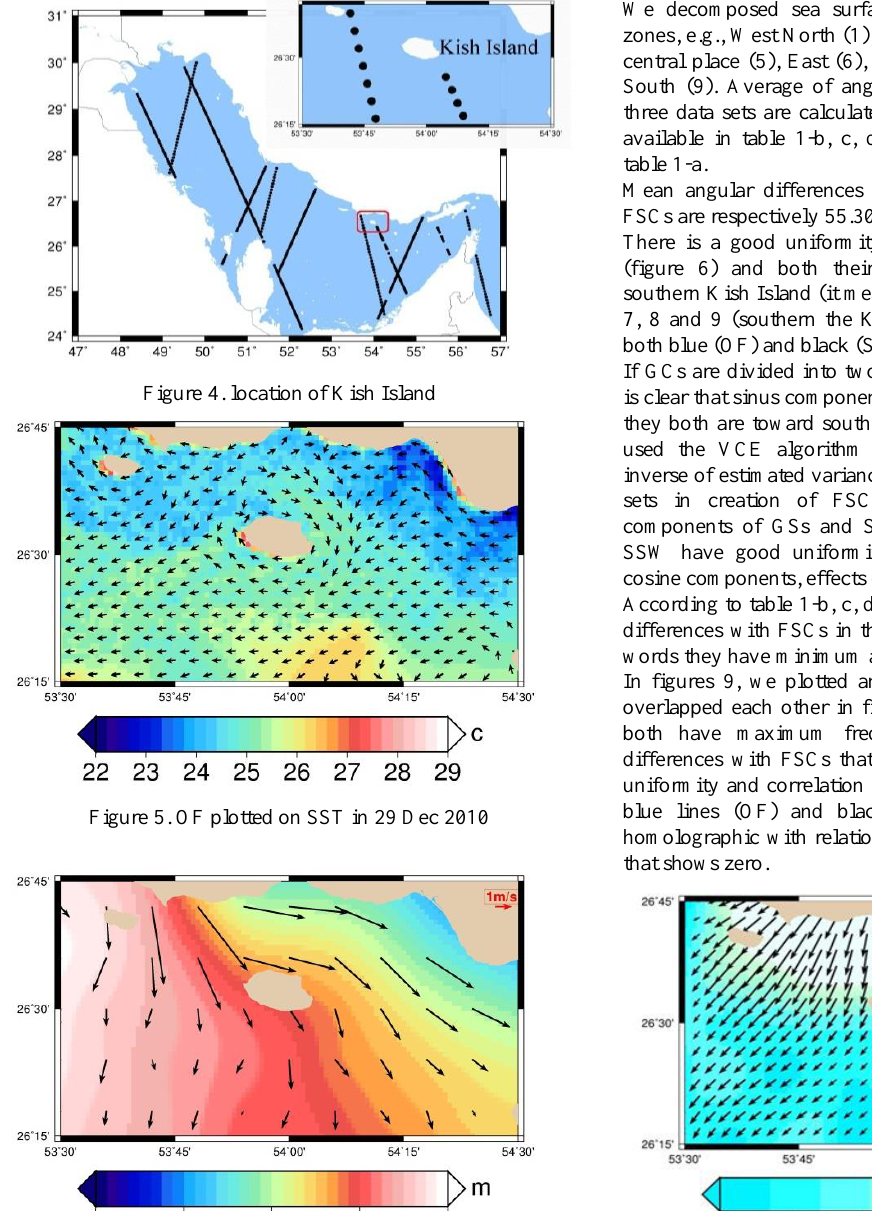
Figure 4. location of Kish Island